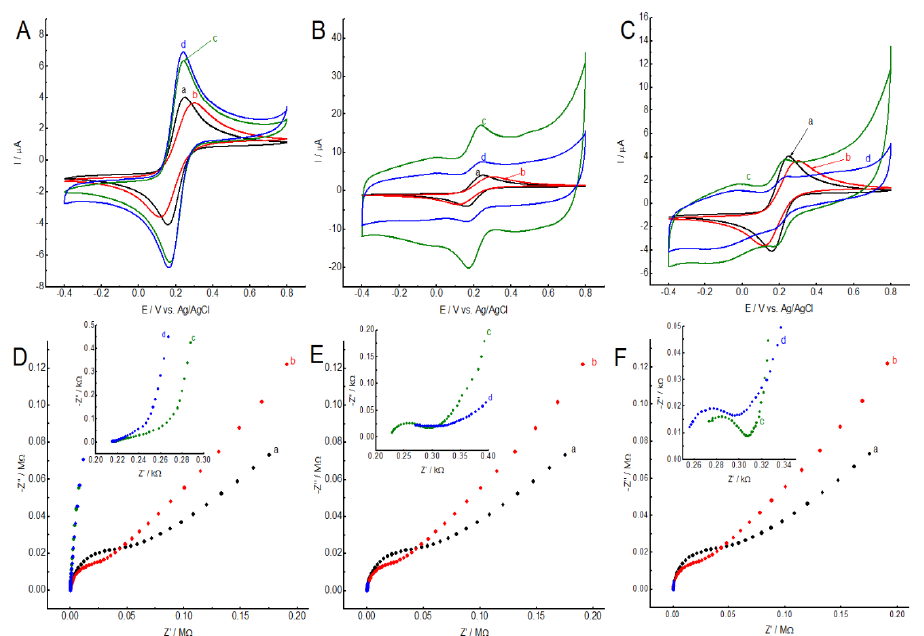
Figure 4. ( A ) Cyclic voltammograms of GC (a, black line), GC/ Pz3 (b, red line), GC/MWCNTs (c, green line), GC/MWCNTs/ Pz3 (d, blue line); ( B ) CVs of GC (a, black line), GC/ Pz3 (b, red line), GC/SWCNTs (c, green line), GC/SWCNTs/ Pz3 (d, blue line); ( C ) CVs of GC (a, black line), GC/ Pz3 (b, red line), GC/rGO (c, green line), GC/rGO/ Pz3 (d, blue line). All CVs were recorded in a phospahate buffer (pH 7.4) containing 1 mM [Fe(CN) 6 ] 3 − at a scan rate of 10 mV s −1 . ( D – F ) Nyquist diagrams of respectively modified electrodes in a phospahate buffer (pH 7.4) containing 1 mM [Fe(CN) 6 ] 3 − /4 − .